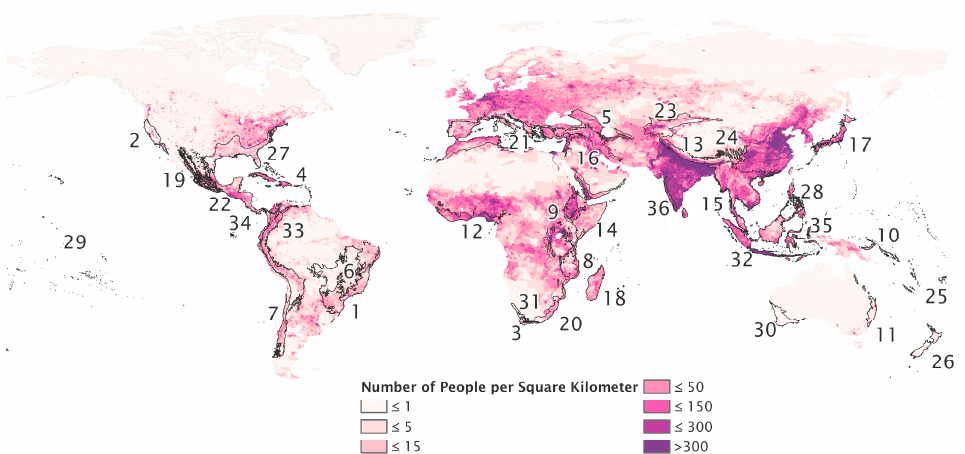
Figure 1. Map showing the human population density (number of people per square kilometer) and the location of the biodiversity hotspots. Hotspots: (1) Atlantic Forest, (2) California Floristic Province, (3) Cape Floristic Region, (4) Caribbean Islands, (5) Caucasus, (6) Cerrado, (7) Chilean Winter Rainfall and Valdivian Forests, (8) Coastal Forests of Eastern Africa, (9) East Melanesian Islands, (10) Eastern Afromontane, (11) Forests of East Australia, (12) Guinean Forests of West Africa, (13) Himalaya, (14) Horn of Africa, (15) Indo-Burma, (16) Irano-Anatolian, (17) Japan, (18) Madagascar and the Indian Ocean Islands, (19) Madrean Pine-Oak Woodlands, (20) Maputaland-Pondoland-Albany, (21) Mediterranean Basin, (22) Mesoamerica, (23) Mountains of Central Asia, (24) Mountains of Southwest China, (25) New Caledonia, (26) New Zealand, (27) North American Coastal Plain, (28) Philippines, (29) Polynesia-Micronesia, (30) Southwest Australia, (31) Succulent Karoo, (32) Sundaland, (33) Tropical Andes, (34) Tumbes-Choco-Magdalena, (35) Wallacea, and (36) Western Ghats and Sri Lanka.